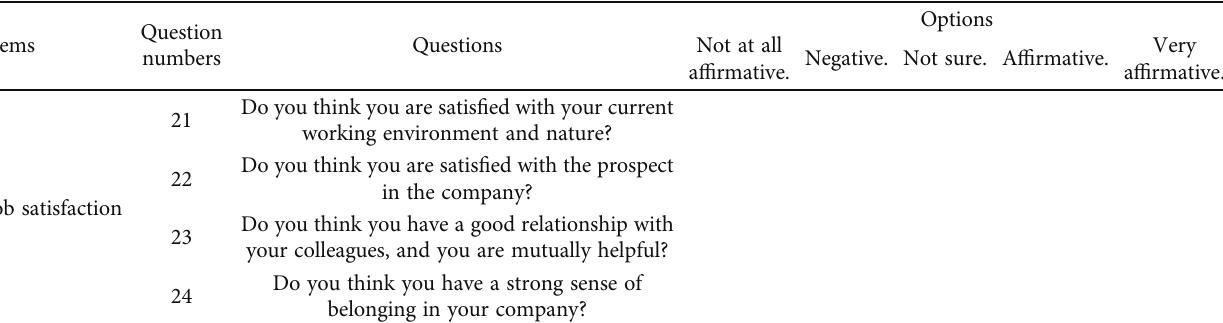
Table 2: Job satisfaction scale.